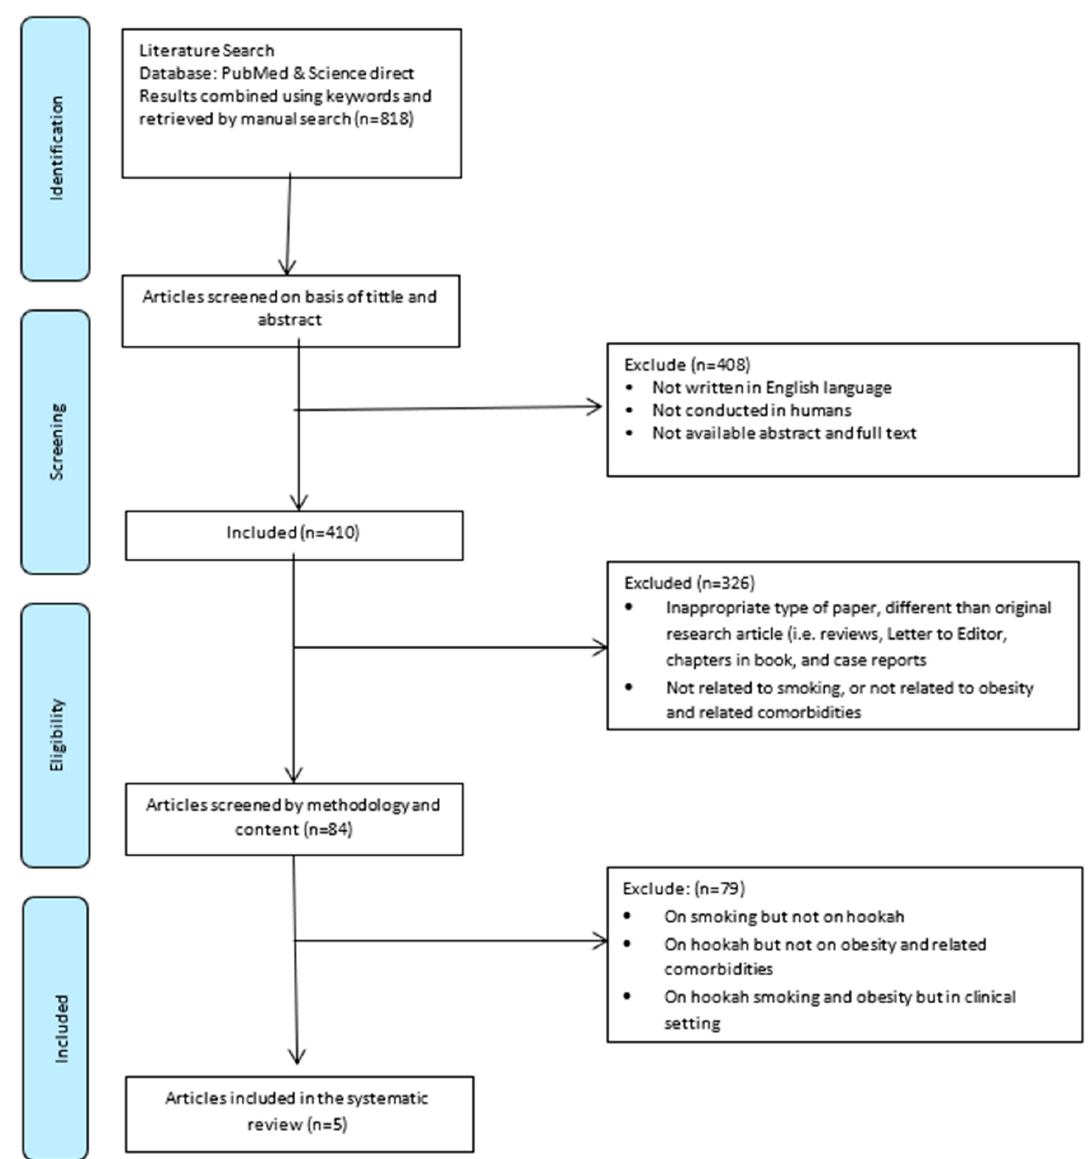
Figure 1. The flowchart summarizing the study selection procedure.